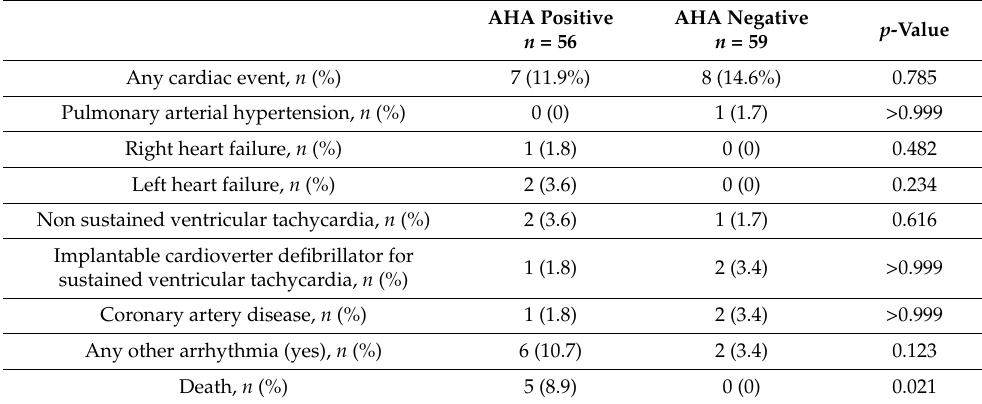
Table 4. AHA positivity and follow-up